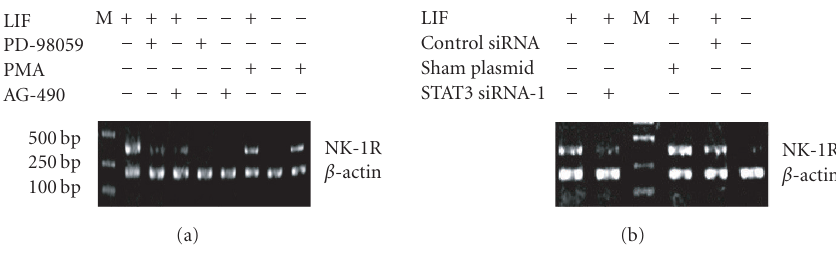
Figure 4: E ff ects of AG-490, PD-98059, PMA, or siRNA-1(STAT3) on LIF-induced expression of NK-1R detected by RT-PCR . RT-PCR was performed on cells that had been preincubated with or without AG-490, PD-98059, PMA, or siRNA-1(STAT3) and then stimulated with LIF. (a) LIF induced expression of NK-1R mRNA, and that was inhibited by AG-490 and PD-98059; PMA increased the expression of NK-1R mRNA in NHBE cells. (b) LIF-induced expression of NK-1R mRNA was inhibited by siRNA-1 against STAT3, but was a ff ected neither by the control siRNA nor the sham plasmid. Experiments were repeated three times with similar results, and the data was expressed as the mean ratio (target/ β -actin) ±